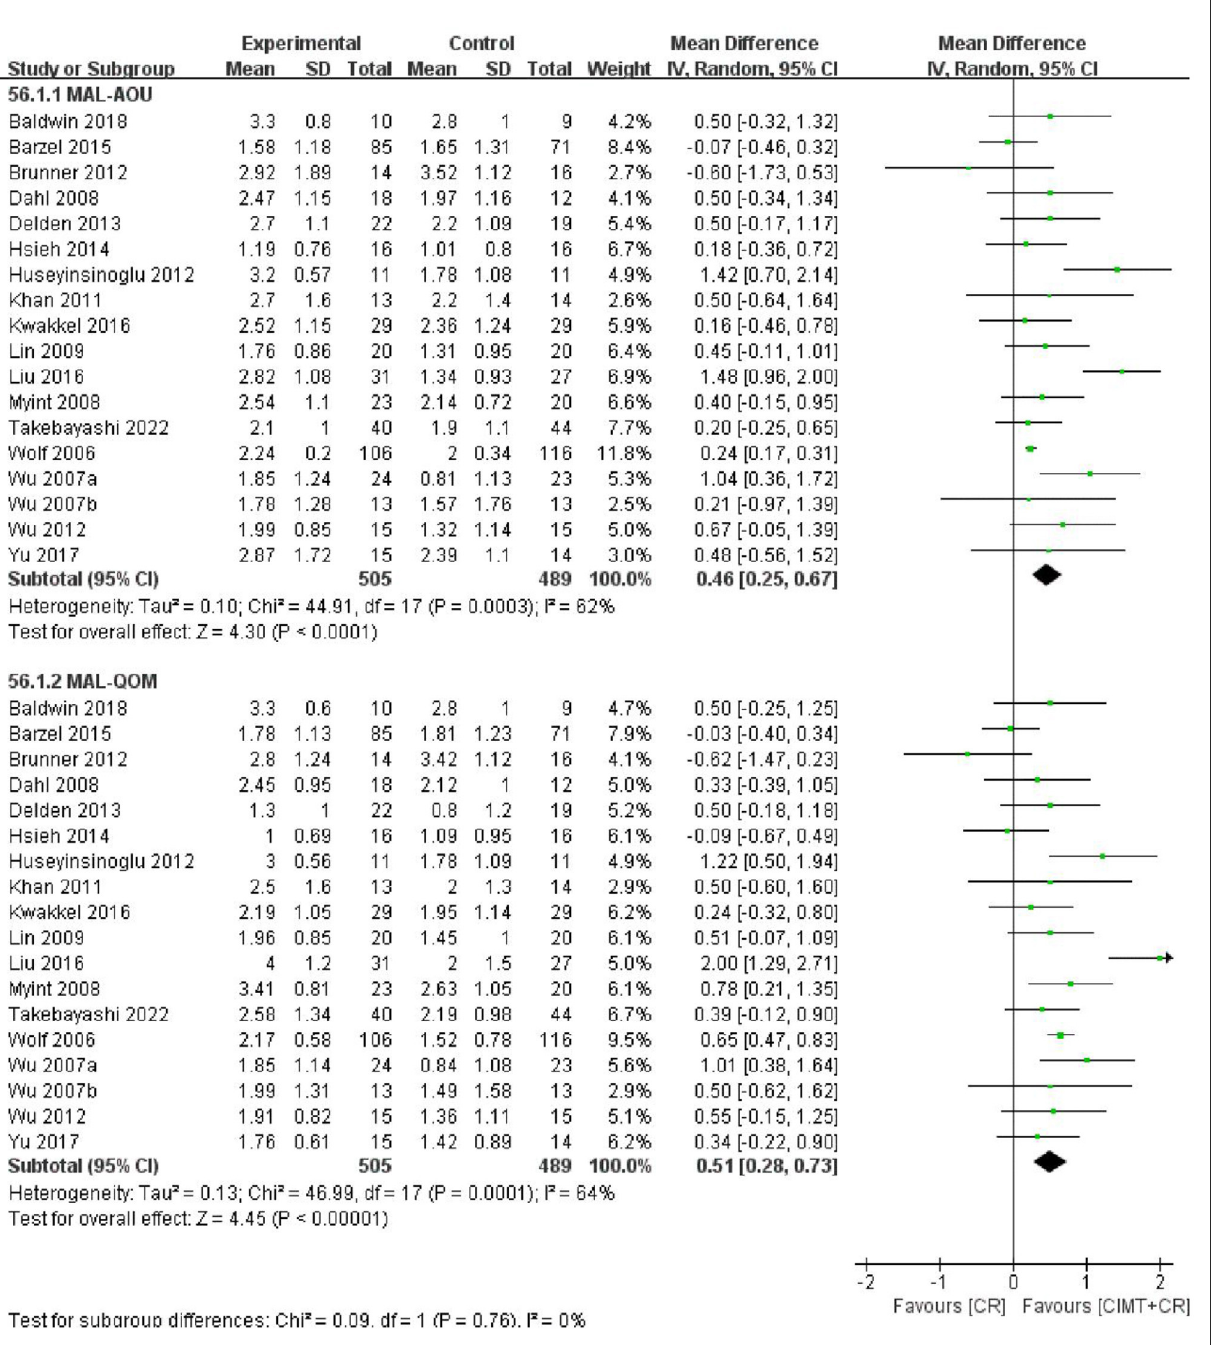
FIGURE3 The forest plot of MAL comparing CIMT plus CR and